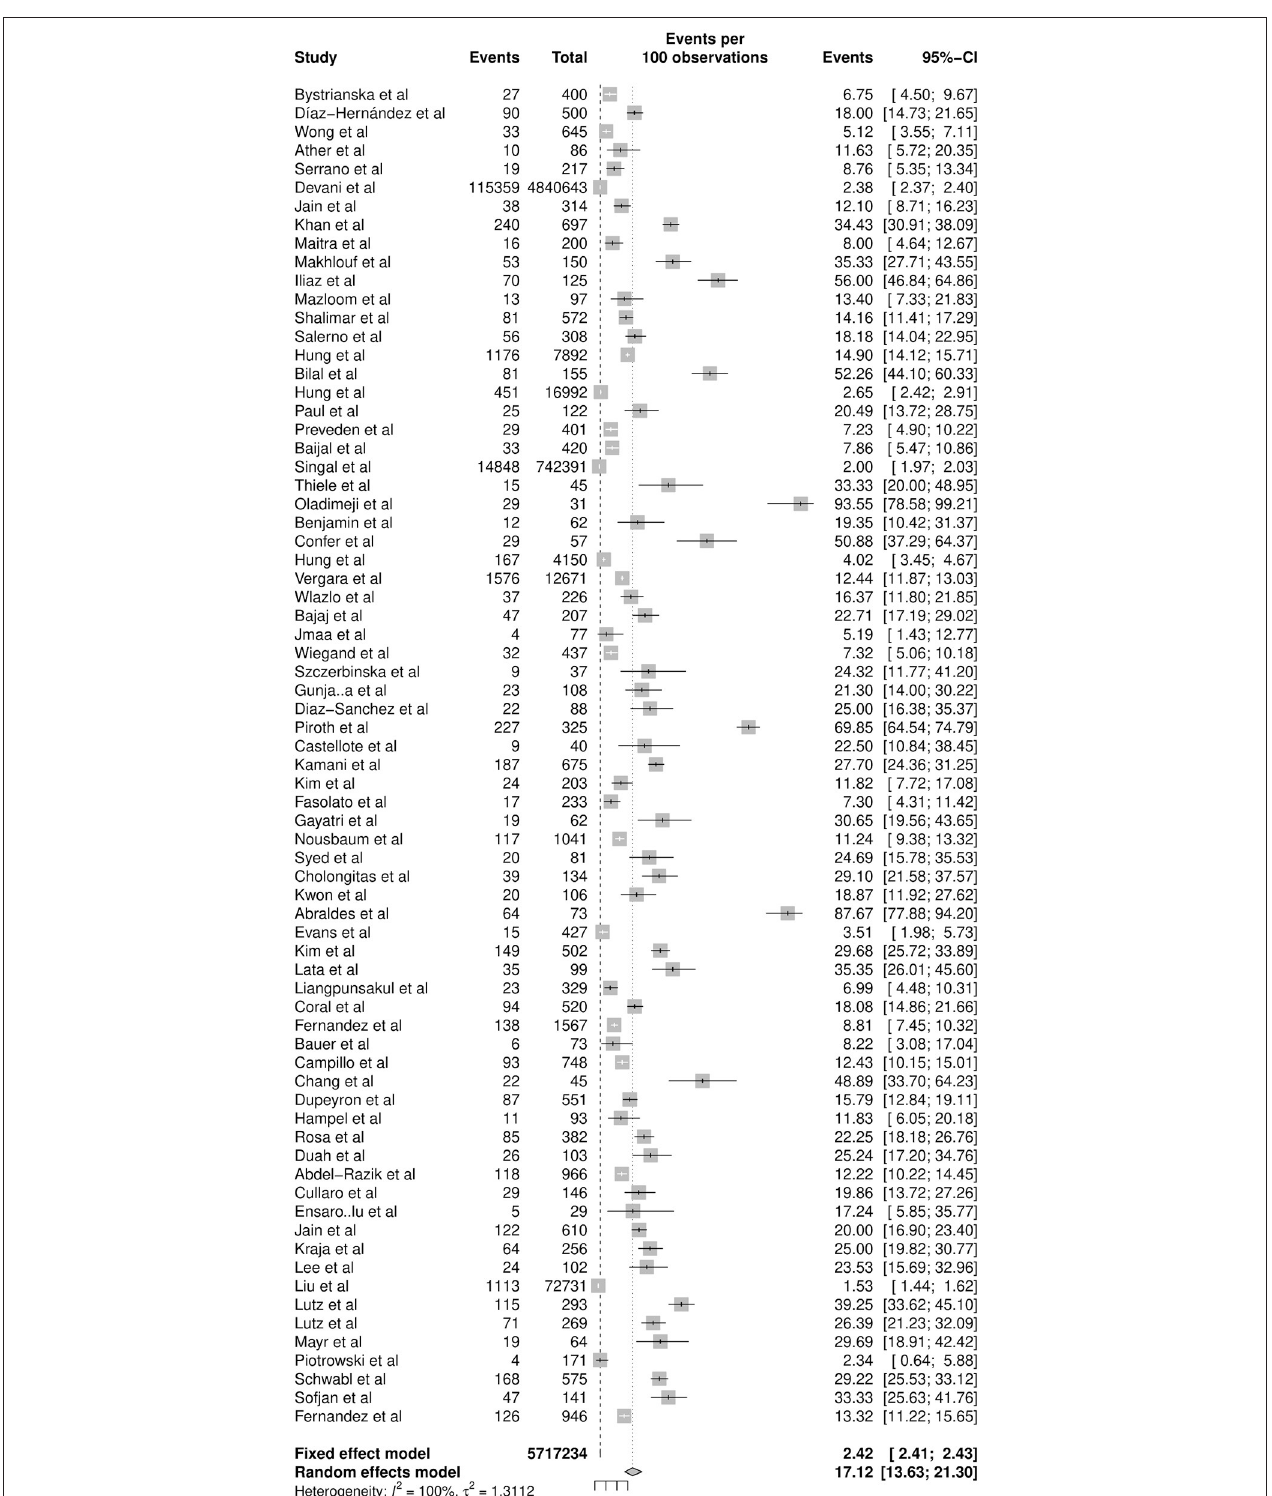
FIGURE 2 | Overall prevalence of SBP in cirrhosis.